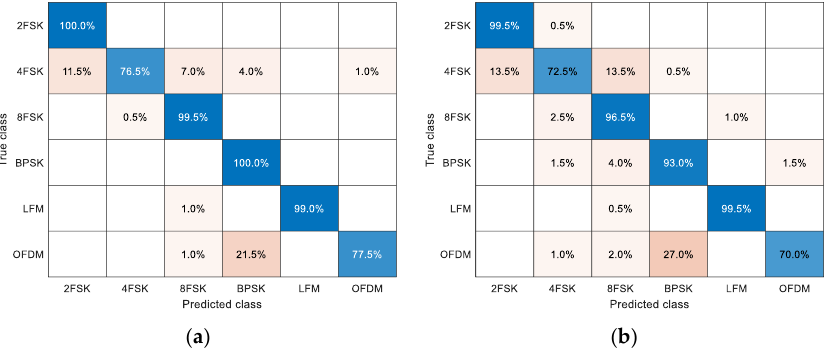
Figure 10. Actual signal recognition confusion matrix. ( a ) The average recognition accuracy of DA is